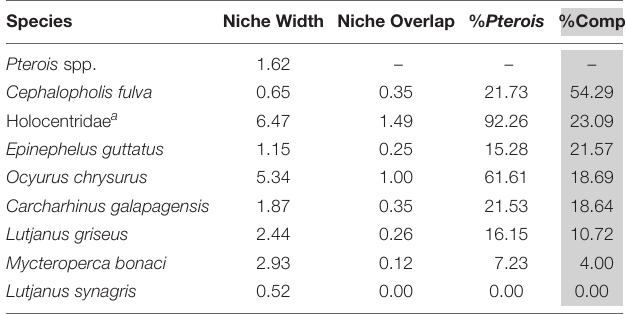
TABLE 5 | Isotopic niche width of eight potential competitors and the overlap in niche with lionfish. Species Niche Width Niche Overlap % Pterois %Comp Pterois